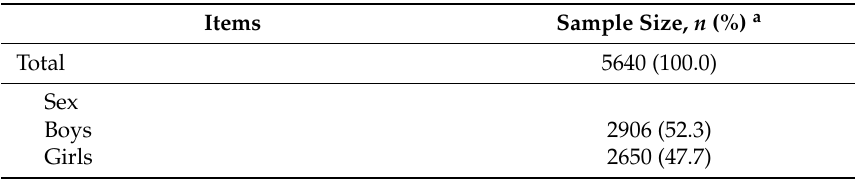
Table 1. Demographic data, covariates, and pneumonia